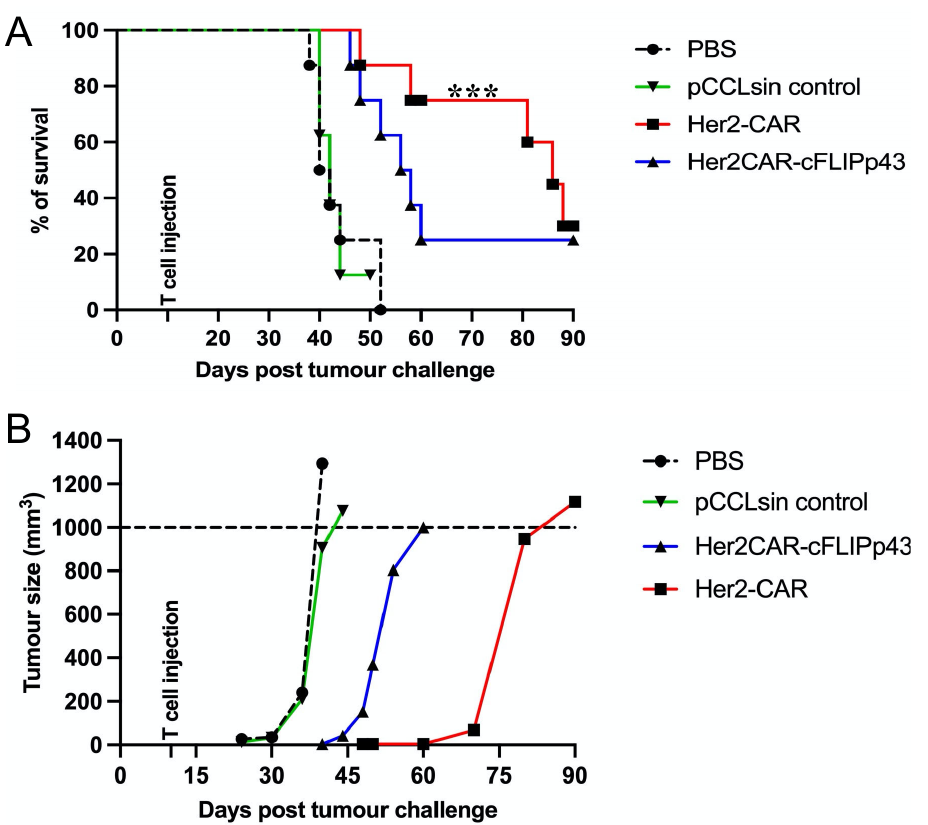
Figure 5. Expression of c ‐ FLIPp43 gene in Her2 ‐ CAR reduces anti ‐ tumour activity in vivo . Thirty ‐ two immunodeficient NOD ‐ scid IL2R gammanull mice were subcutaneously injected with 2 × 10 6 human Her2 + MCF ‐ 7 cells. The tumour ‐ bearing mice were randomly treated ( n = 8) with PBS, pCCLsin con ‐ trol ‐ transduced T cells, 1 × 10 7 Her2 ‐ CAR T cells or 1 × 10 7 Her2CAR ‐ cFLIPp43 CAR T cells. For 90 days post ‐ inoculation, tumour ‐ bearing mice were monitored, and tumour volume was measured every alternate day. ( A ) Kaplan–Meier survival curve showing cumulative humane endpoint (sur ‐ vival) differences between treatment groups and ( B ) mean tumour volumes of each group. Statisti ‐ cal analysis using Log ‐ rank (Mantel–Cox) testing, *** p < 0.001.